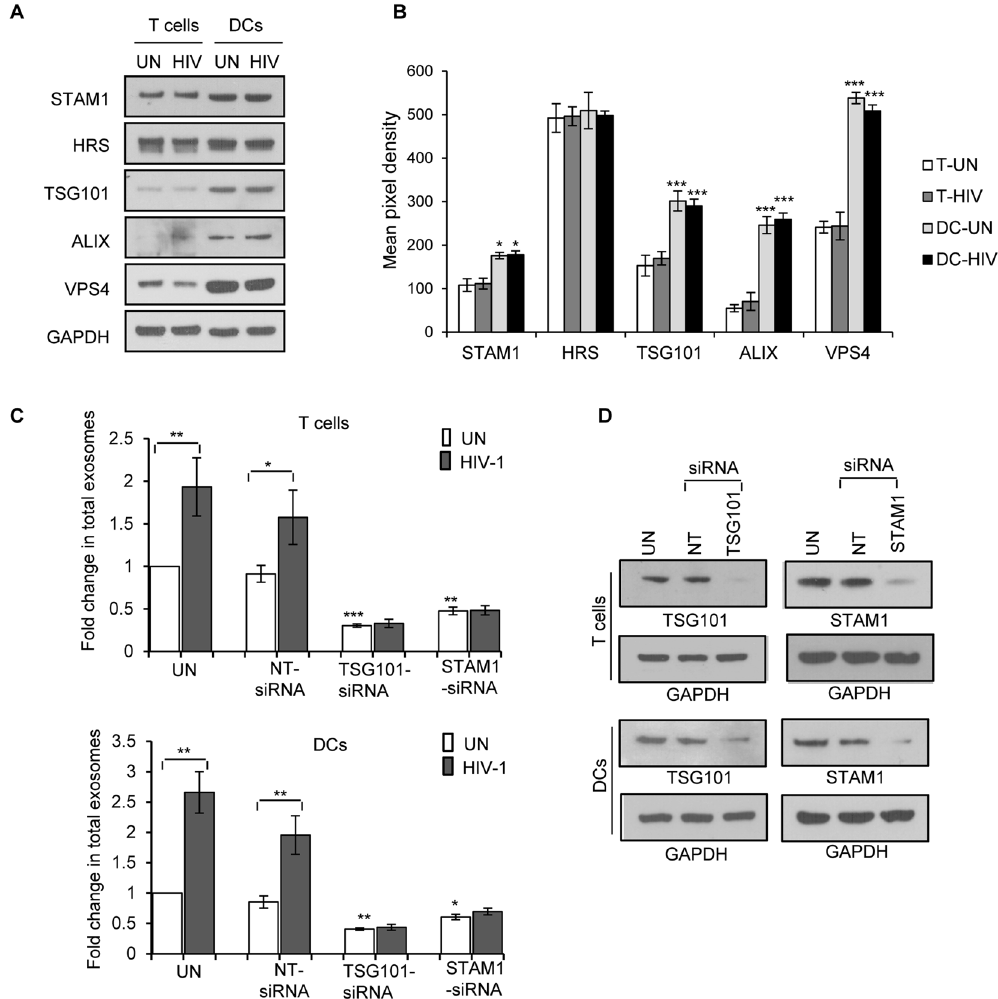
Figure 6. Analysis of molecules involved in exosome biosynthesis in T cells and DCs. ( A ) Representative Western blot images of indicated molecules in total cell lysates from uninfected (UN) and HIV-1 infected (HIV) T cells and DCs after 3 days. GAPDH used as loading control. ( B ) Quantitative analysis of Western blot images of ( A ); the band intensity of each lane was determined by Image J software and pixel density was calculated. The data represents mean of triplicates ± SE from three independent experiments. ( * p ≤ 0.05, ** p ≤ 0.01, *** p ≤ 0.001, p-values for STAM 1- 0.019, 0.03; TSG101-0.00018, 0.00013, ALIX-0.00026, 0.001, VPS4-0.00012, 0.00031). ( C ) Fold change in total exosomes in siRNA-TSG101 or siRNA-STAM1 transfected T cells and DCs. Fold change was calculated by considering exosome release from untreated and uninfected cells as 1 (unfilled bars-uninfected cells; filled bars- HIV-1 infected cells). The data represents mean of three independent experiments ( * p ≤ 0.05, ** p ≤ 0.01, *** p ≤ 0.001, p-values of T cells are 0.0073; 0.0221; 0.00098; 0.005697262. p-values of DCs are 0.0010; 0.00462; 0.0016; 0.023). ( D ) Representative Western blot images showing the expression of TSG101 and STAM1 in untreated (UN), control siRNA (NT) and siRNA-TSG101 or siRNA-STAM1 transfected T cells or DCs. GAPDH used as loading control. Full-length blots are presented in Supplementary Figure